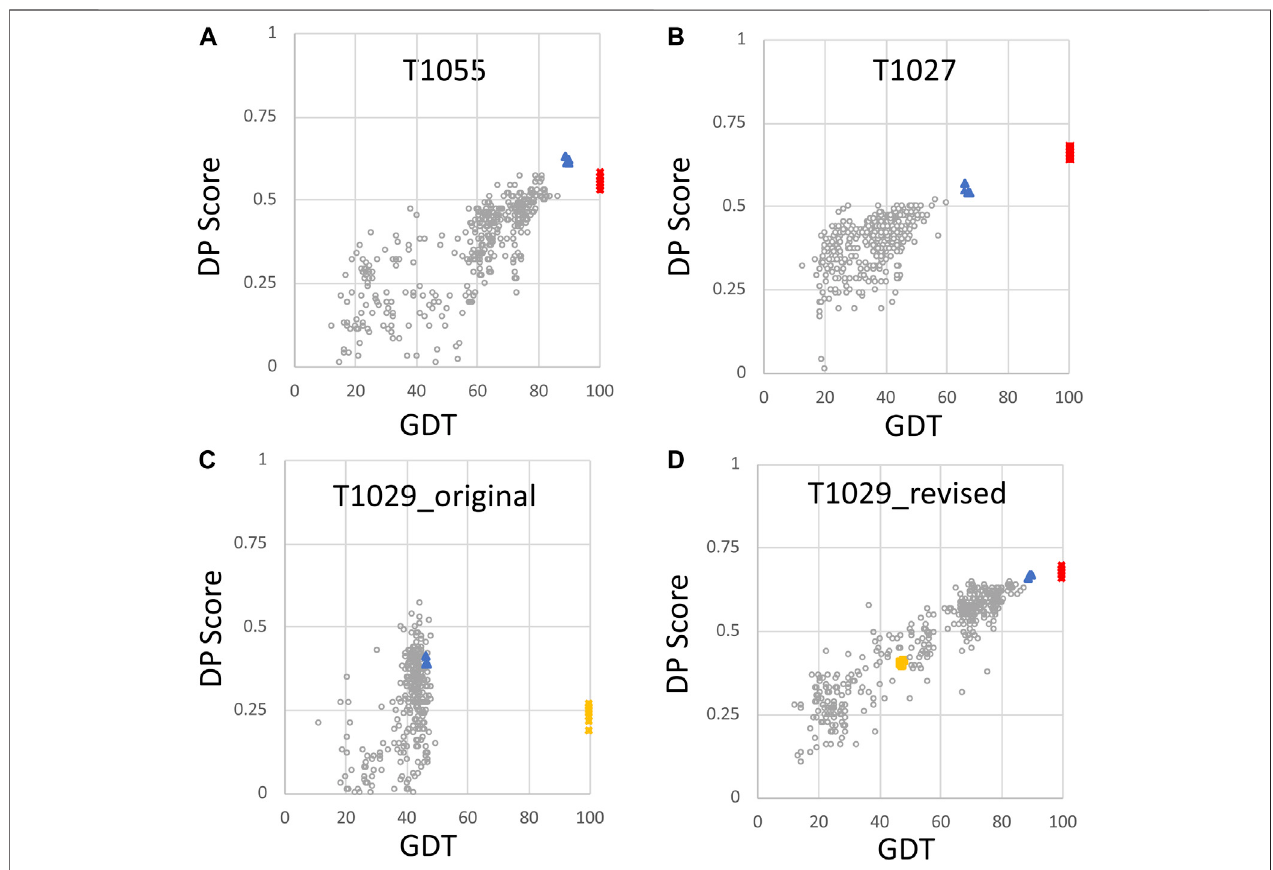
FIGURE 2 | Plots ofDPscore vs. GDT for NMR and AlphaFold models. Foreachmodel, the DP score compares modelvs. NMR NOESY peaklistdata,and the GDT scoreisameasureofsimilaritytotheNMRconformerwithbestDPscore(Huangetal.,2021).Plotsareprovidedfor (A) targetT1055(511CASP14models;linearcorrelation